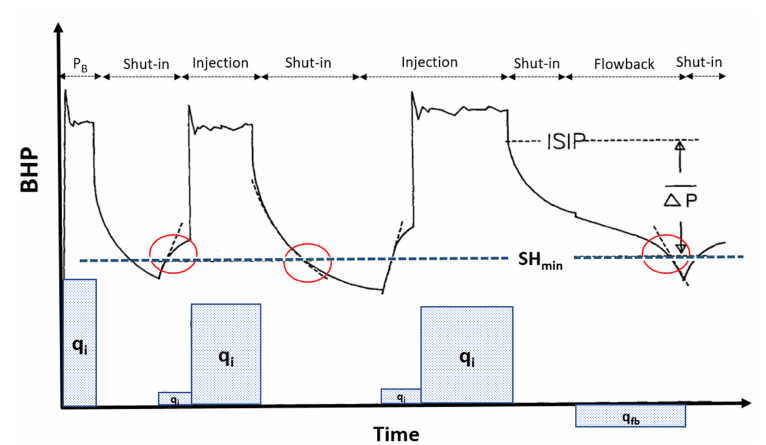
Figure 3. Micro-fracture test shows multi-injection cycles